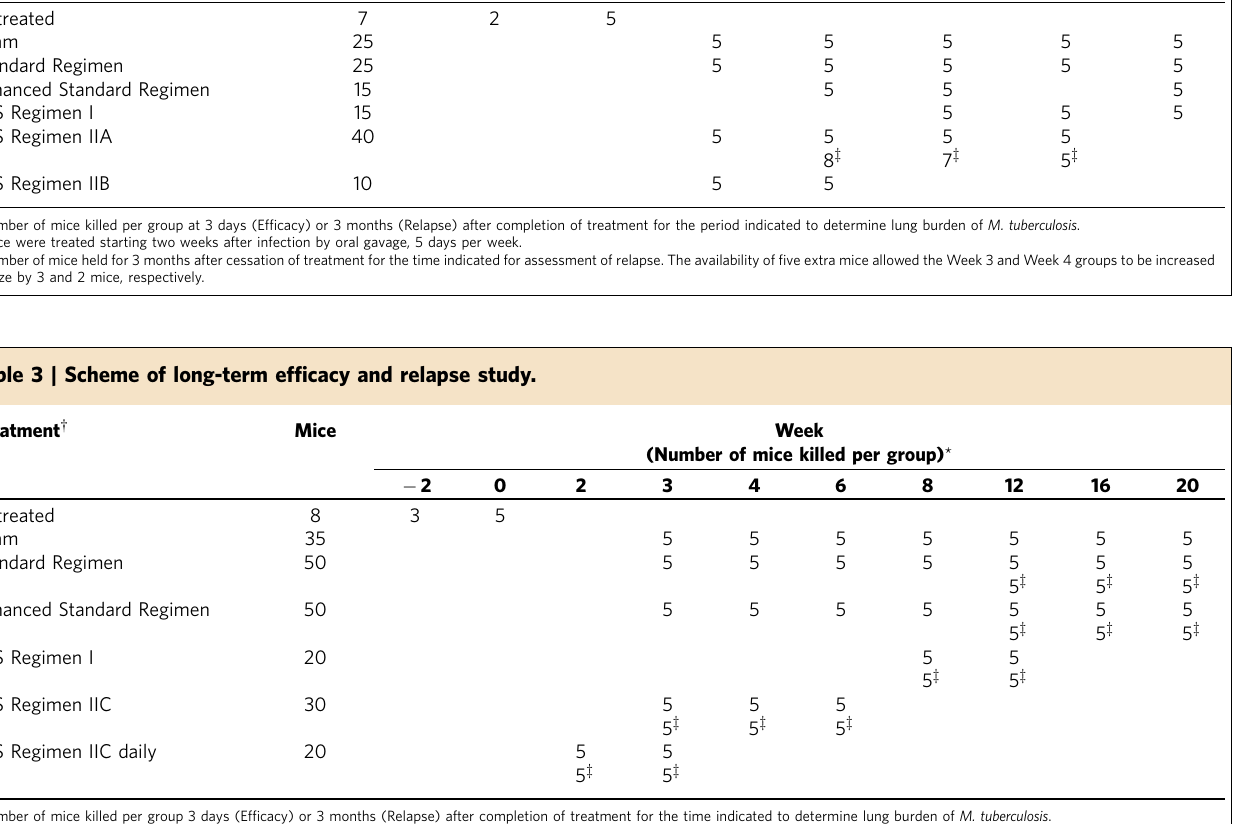
(Number of mice killed per group) *